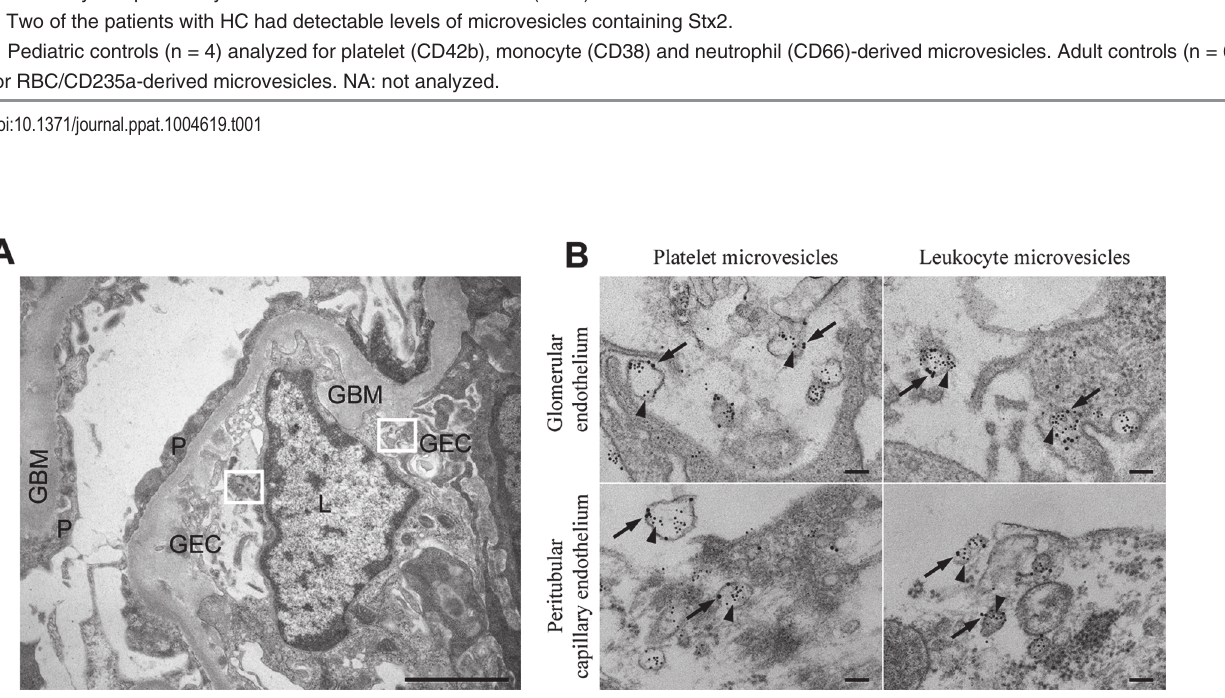
Fig 1. Stx2-containing blood cell-derived microvesicles detected in the renal cortex of a HUS patient. ( A ) Ultramorphology showing an overview from the renal cortex of a patient with HUS (patient 14) including a glomerular capillary with two boxes magnified in (B). Scale bar: 2 μ m. P: podocyte, GEC: glomerular endothelial cell, GBM: glomerular basement membrane, L: leukocyte. ( B ) Renal cortex of a the same HUS patient labeled with anti-Stx2 (5 nm, arrowhead), anti-CD42b (10 nm, arrow) to detect platelet-derived microvesicles or anti-CD45 (10 nm, arrow) to detect leukocyte-derived microvesicles. Microvesicles were defined by their size (shed microvesicles: (cid:1) 1 μ m, apoptotic bodies: 1 – 5 μ m) and their cellular origin based on the presence of platelet- or leukocyte-markers. Stx2-containing microvesicles were detected in glomerular- and peritubular capillary endothelium. The two upper panels are magnifications of the two boxes depicted in (A). Scale bar: 100